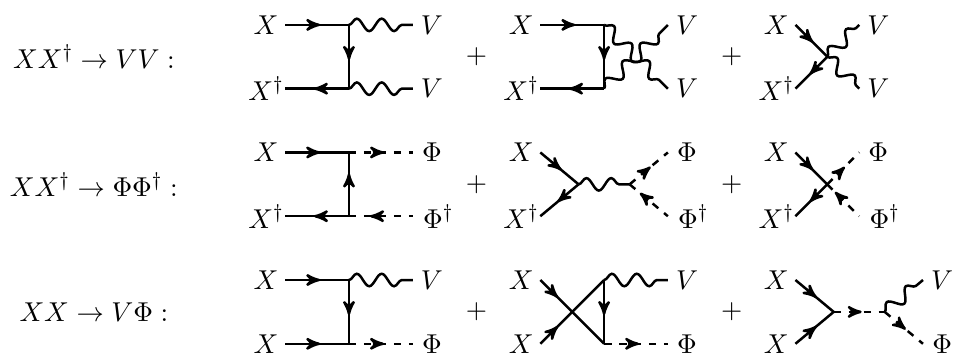
Figure 9 . The tree level diagrams contributing to the annihilation of XX y , XX and X y X y pairs. Note that for the XX y ! V V and XX ! (cid:8) V annihilation processes, there are both t - and u - channel diagrams. In contrast, there is no u -channel diagram for XX y ! (cid:8)(cid:8) y . The arrows denote the (cid:13)ow of the U(1) D charge.